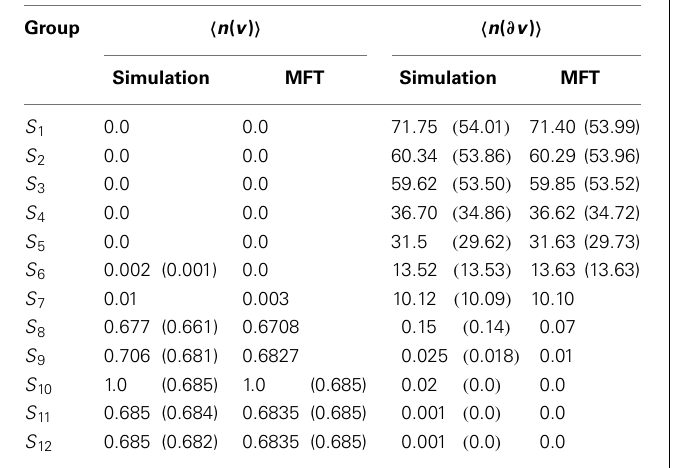
Table 1 | 12-Group architecture with self after reorganization .